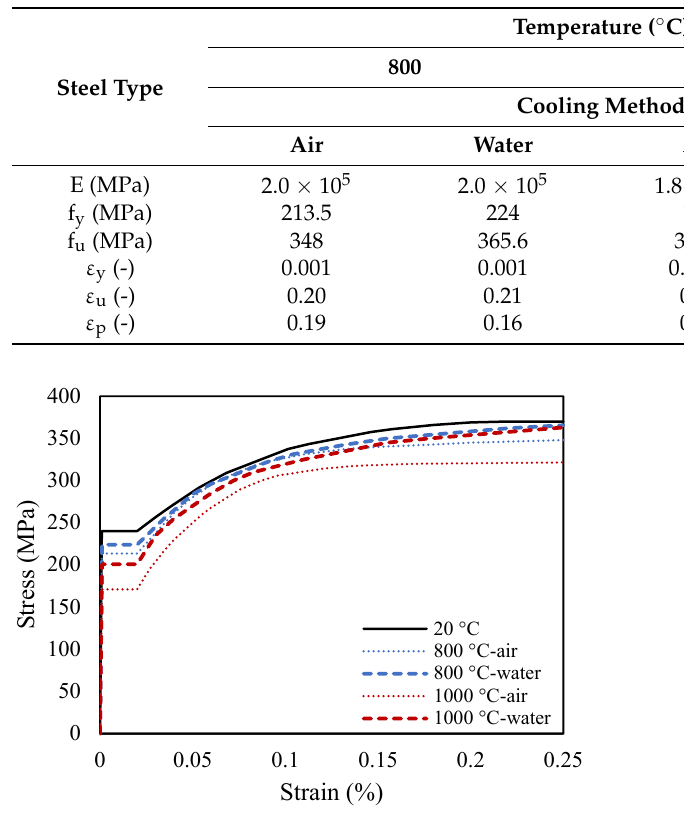
Figure 3. Stress–strain curve of steel material at the elevated temperatures.